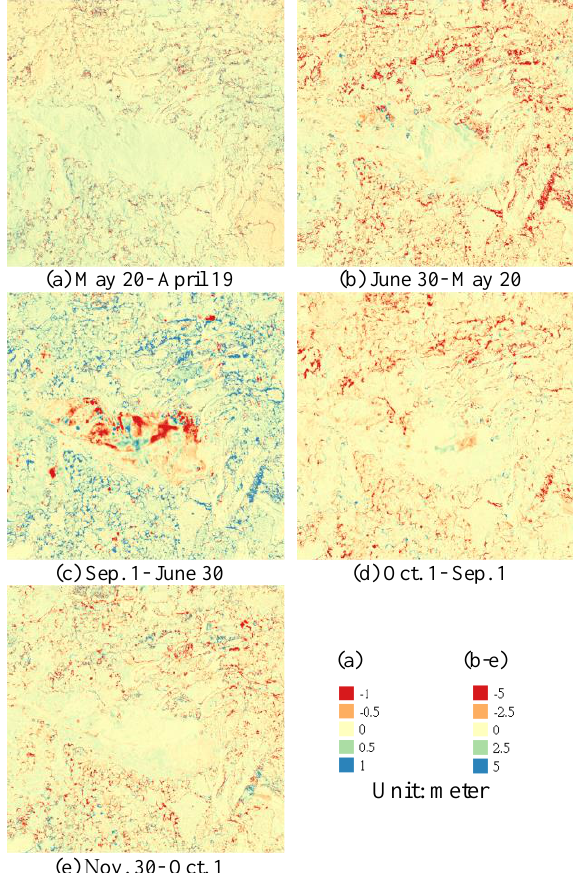
Figure 14. DSM elevation difference between two neighbour